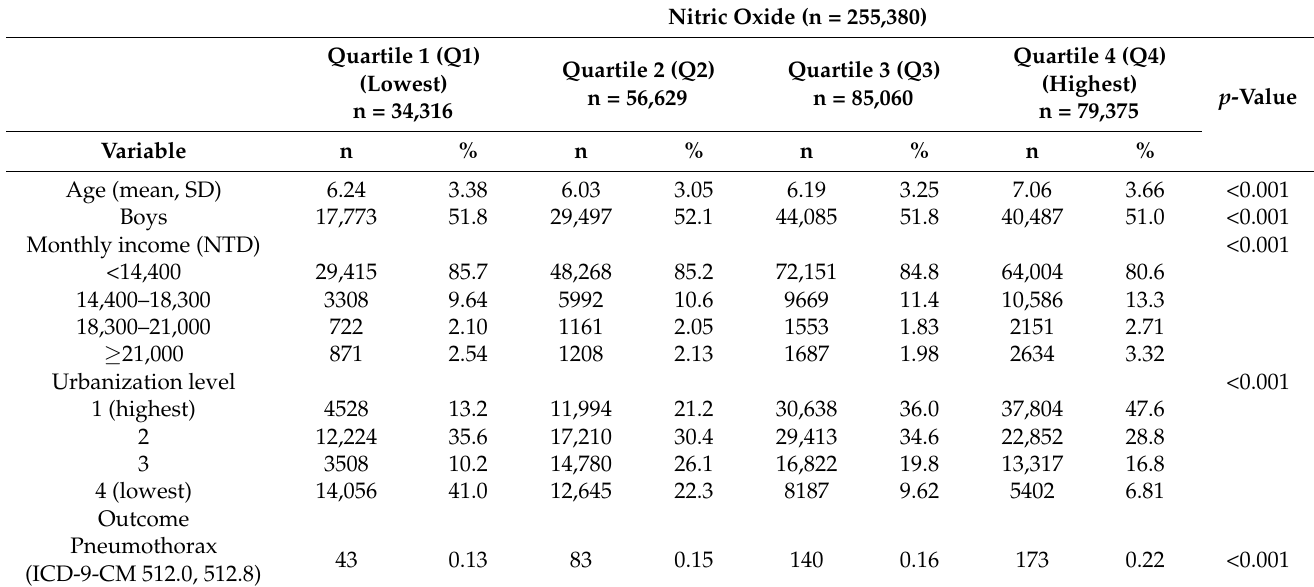
Table 1. Characteristics of participants exposed to various annual average concentrations of nitric oxide.